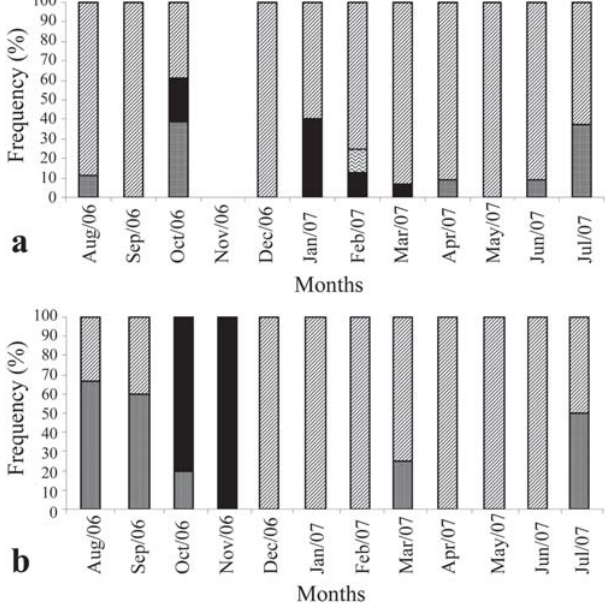
Fig. 3. Relative frequency of P . mesopotamicus females in the headwaters - Rosário Oeste, MT (a) and in the flood area - Poconé, MT (b) according to the stages of gonadal maturation ( MG; MA; SP and RE) between August 2006 and July